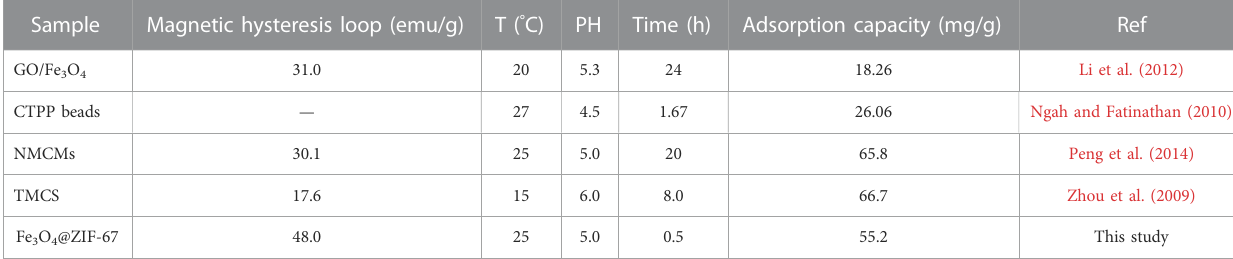
TABLE 3 Comparison of adsorption conditions of different